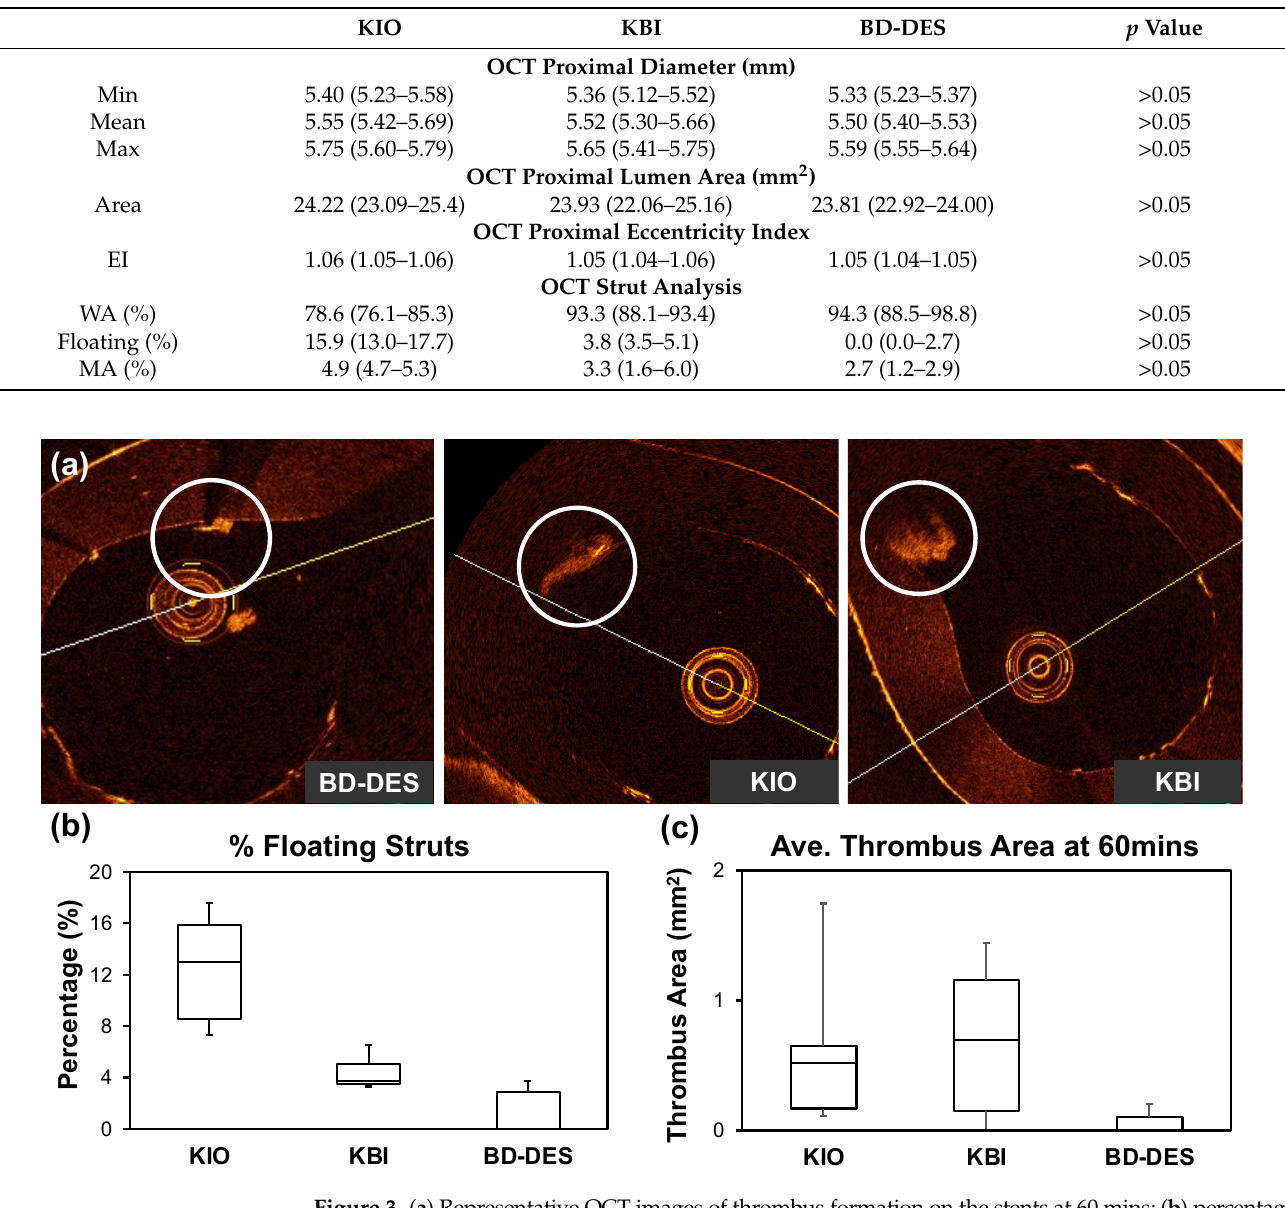
Figure 3. ( a ) Representative OCT images of thrombus formation on the stents at 60 mins; ( b ) percentage of floating struts and ( c ) average thrombus area based on OCT quantification, n = 5.